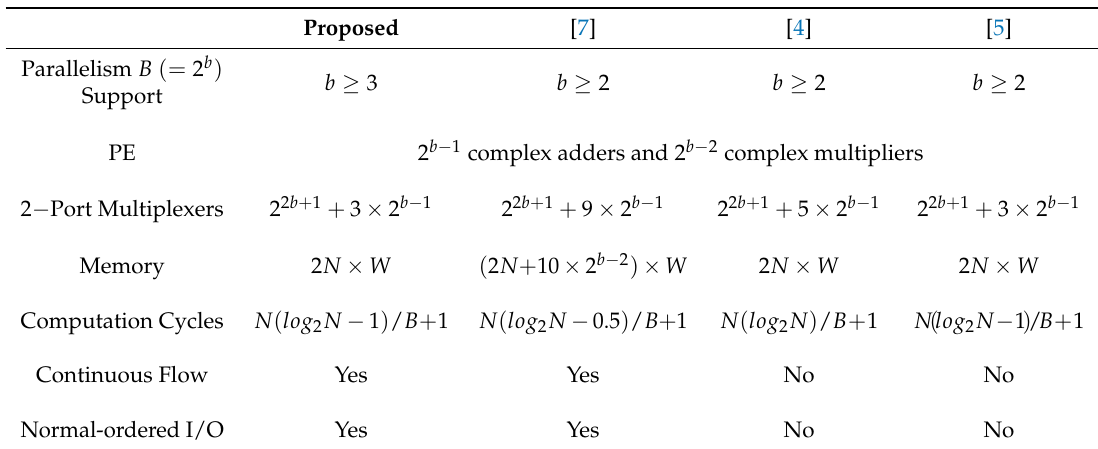
Table 2. Comparison of the RFFT